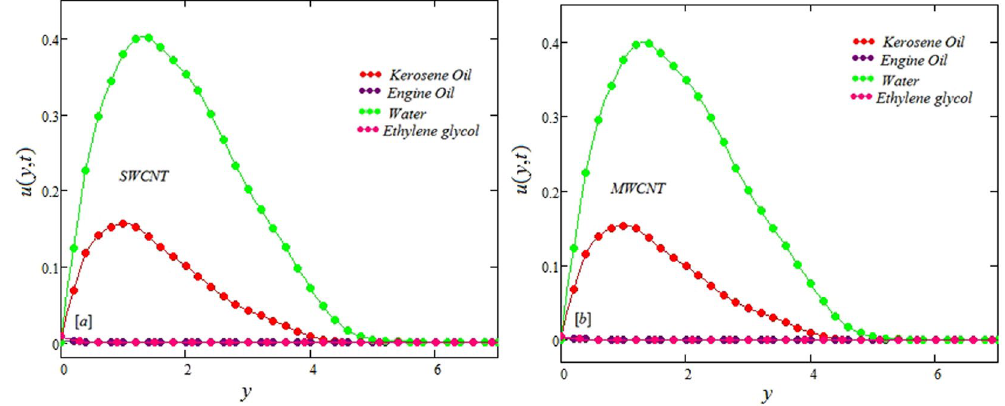
Figure 11. Comparison of velocity profiles for single and multiple wall CNTs for different base fluids.